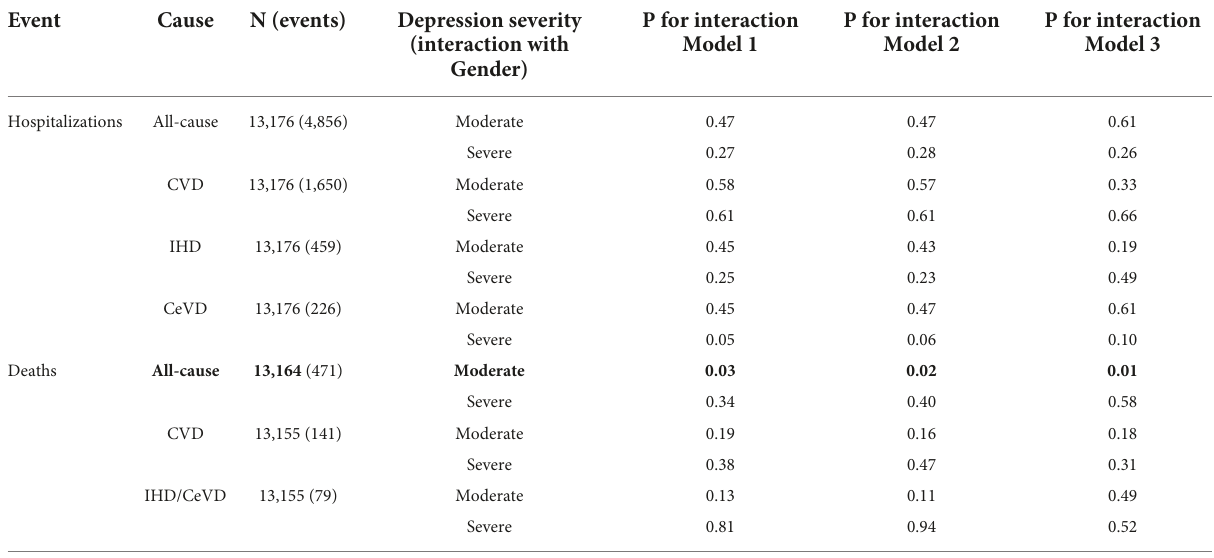
TABLE 2 Associations of gender-by-depression severity interaction with incident hospitalization risk and mortality.